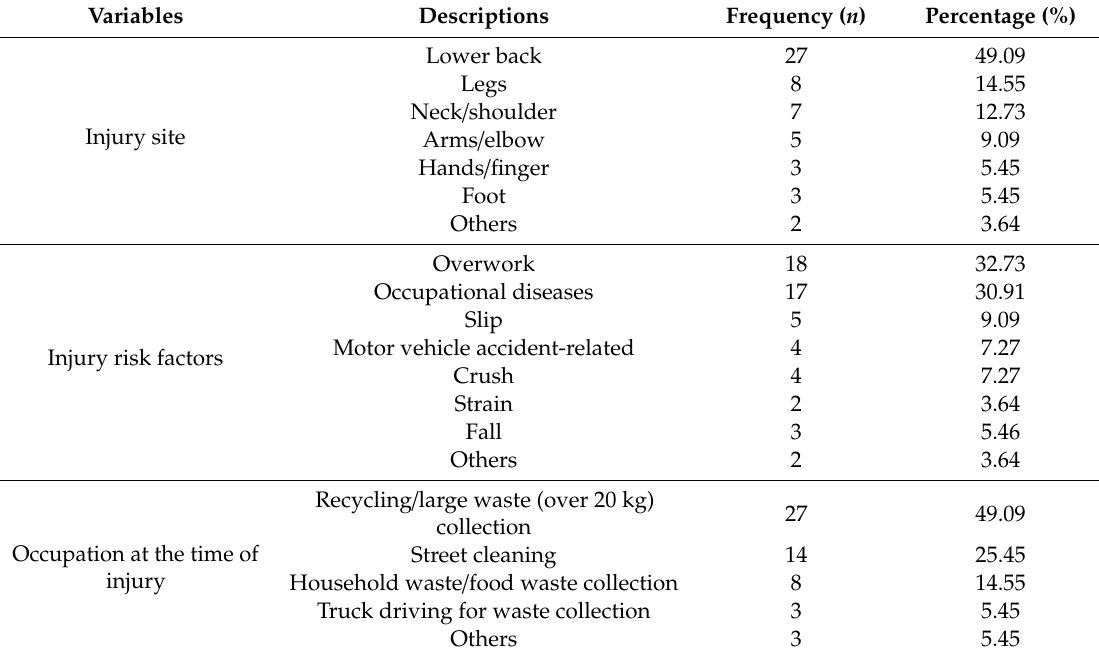
Table 4. Injury sites, risk factors, and occupation at the time of injury (N =